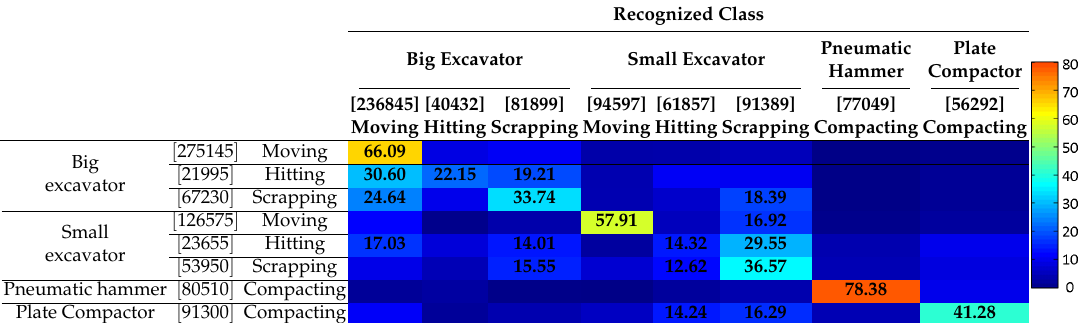
Table 5. Confusion matrix of the product combination method from medium and long window sizes for the machine + activity identification mode. Classification accuracy is shown in each cell. The values between brackets represent the number of frames that are classified as the recognized class or that belong to the real class.